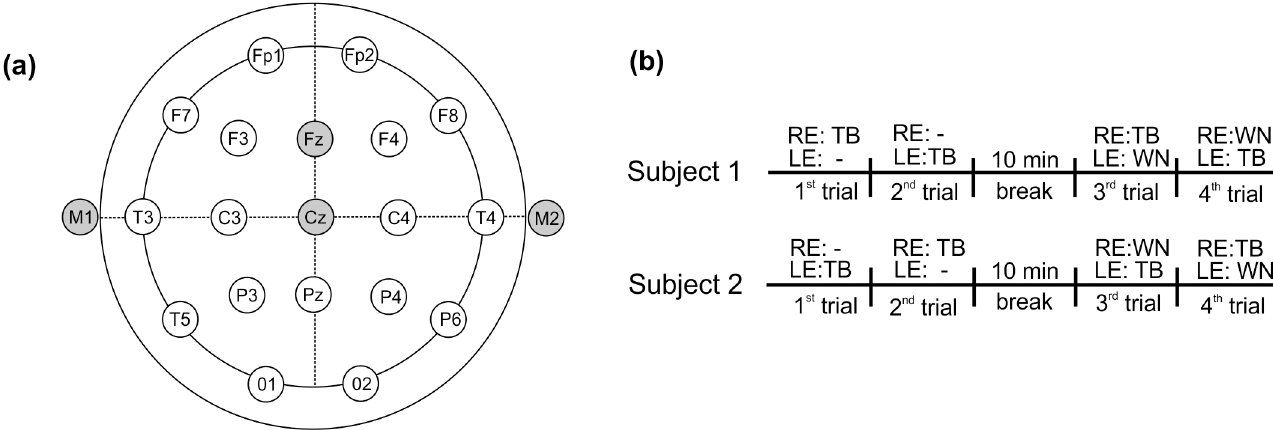
Fig 1. (A) An schematic illustration showing the electrodes setup based on the 10 – 20 system. (B) Schematic diagram of the time course of the experiments. The order of the tested ear was alternated between subjects, which means that if subject 1 was tested on the right ear (RE) first, the next subject was tested in the opposite order.